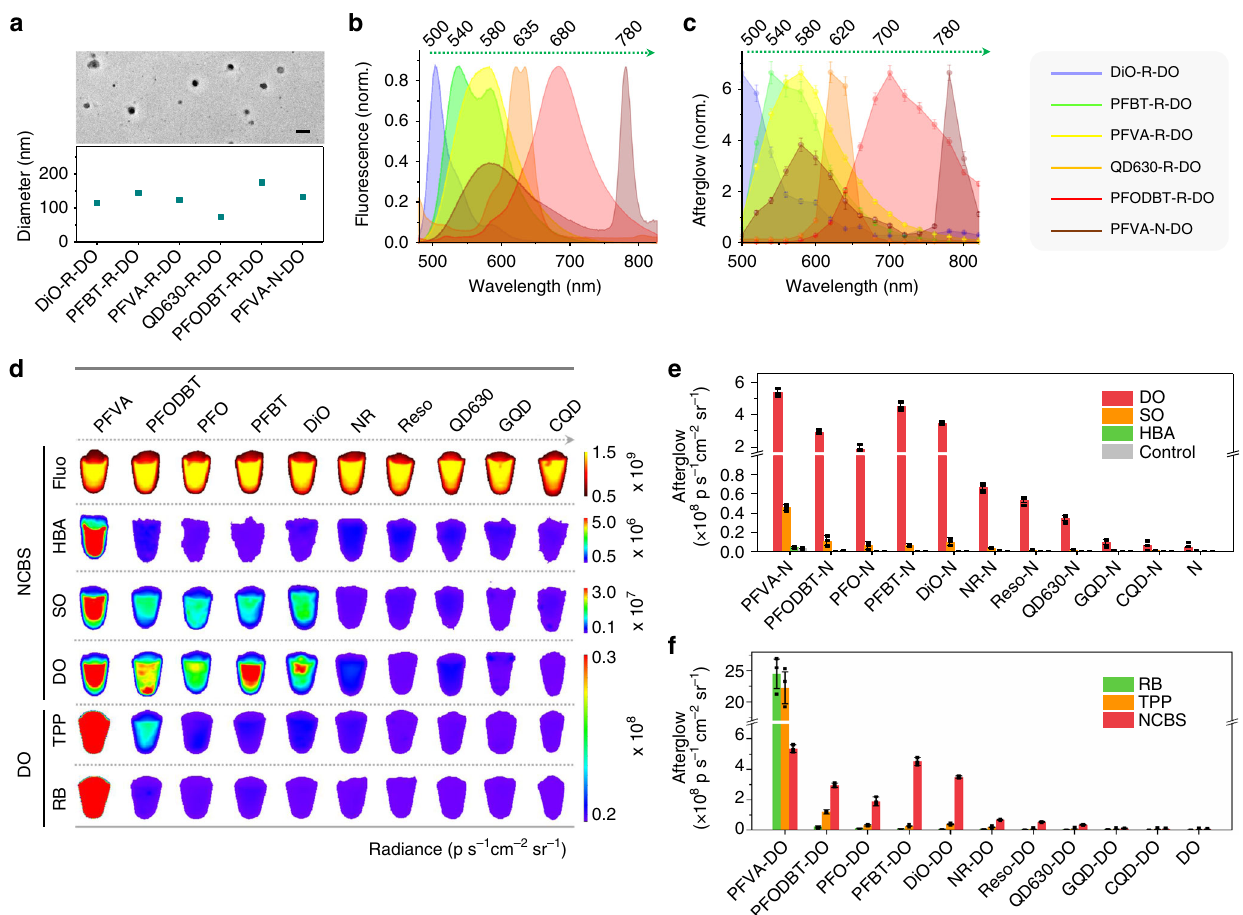
Fig. 2 Characterization of ALNPs with different components. a Representative TEM image of PFVA-N-DO ALNPs (upper panel) and representative hydrodynamic diameters of various ALNPs measured by DLS (bottom panel) in 1 × PBS (phosphate buffered saline) buffer (pH = 7.4). Scale bar: 200 nm. b Normalized (norm.) fl uorescence spectra of representative ALNPs with the emission ranging from visible to NIR region in 1 × PBS buffer (pH = 7.4). c Normalized afterglow luminescence spectra of ALNPs in ( b ) in 1 × PBS buffer (pH = 7.4). d Fluorescence and afterglow images of ALNPs with various components. Fluorescence images of NCBS based ALNPs were acquired at 780 nm upon excitation at 710 nm. Afterglow images were captured after light pre-irradiation (1 W cm − 2 808 nm for NCBS based ALNPs while 0.1 W cm − 2 white light for RB or TPP based ALNPs) for 5 s. For all ALNPs, [afterglow initiator] = 0.75 μ g mL − 1 (2.5 w/w%), [afterglow substrate] = 15 μ g mL − 1 (50 w/w%), [afterglow relay unit] = 30 μ g mL − 1 . e Quanti fi cation of afterglow intensities of ALNPs with the same afterglow initiator (NCBS) whereas varying substrates and relay units in ( d ). f Quanti fi cation of afterglow intensities of ALNPs with the same afterglow substrates (DO) whereas varying afterglow initiators and relay units in ( d ). Error bars indicated standard deviations